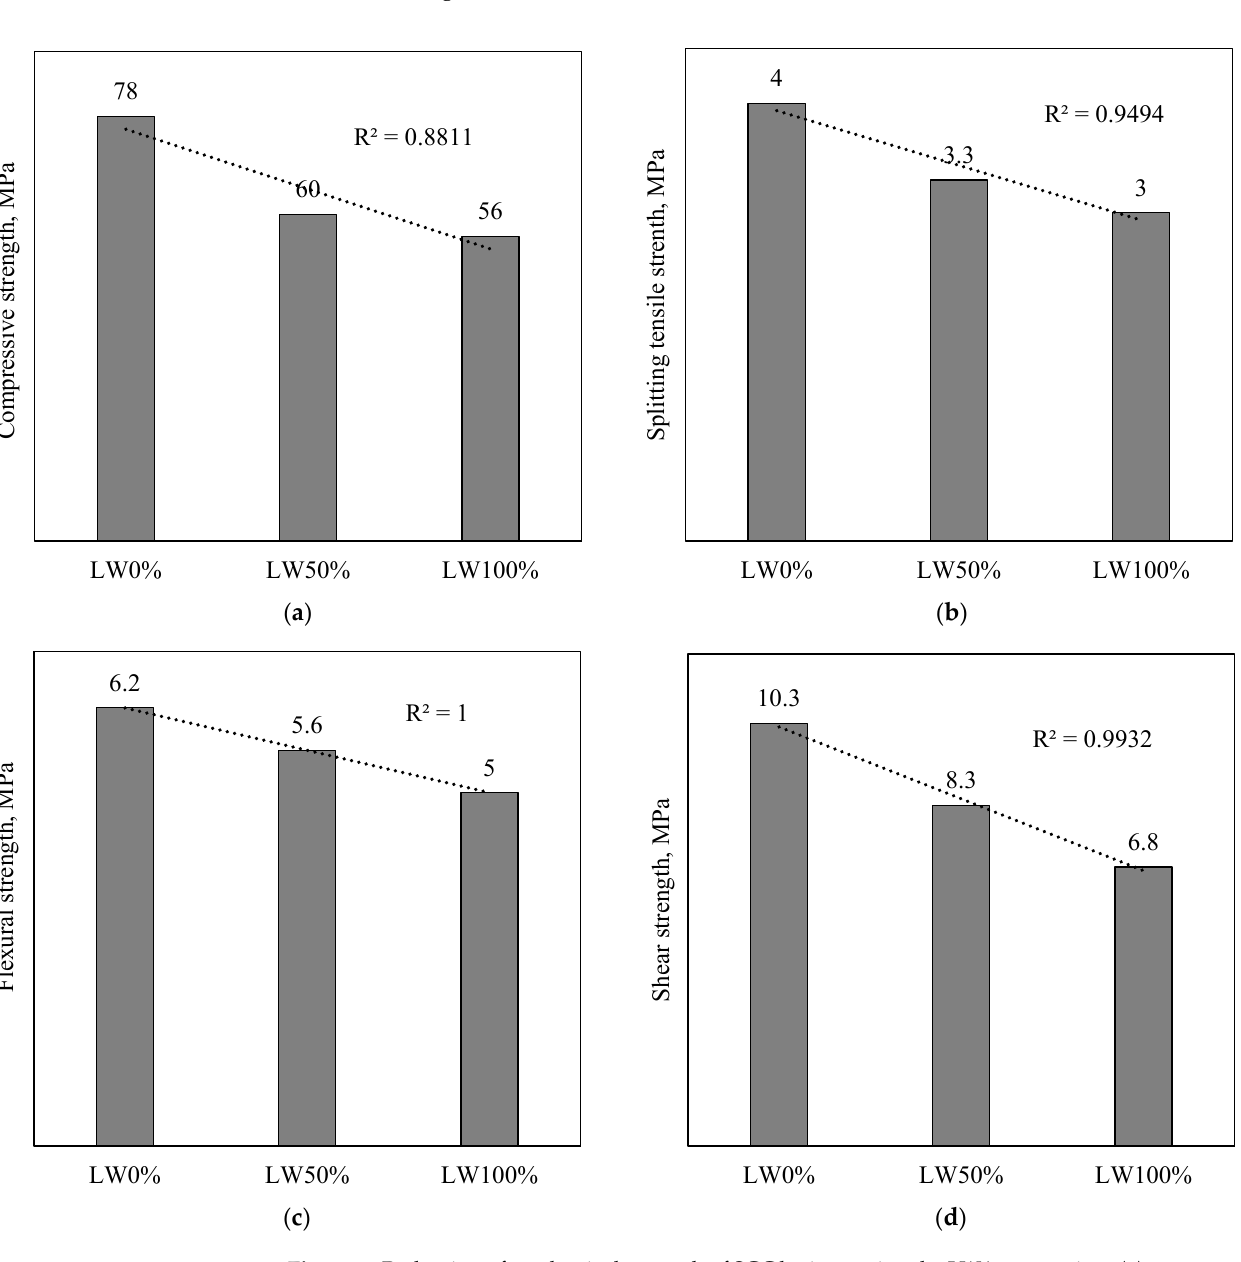
8.3 MPa, and 6.8 MPa, respectively. 3.3. Schmidt Hammer Rebound Value and Density The Schmidt hammer test is a non-destructive test used to measure the elastic properties or the concrete strength. Rebound values and density measurements were carried out on the SCC concrete cubes with different LWA proportion ratios. They were correlated linearly with a coefficient of determination of 0.99, as shown in Figure 7, as both of them were affected by the aggregate type [44]. Rebound values were influenced by LWA’s lower strength and bulk density as well as its high absorptivity. Rebound values decreased from 49.64 for LW0% (red circle) to 43.47 for LW100% (green circle), while the density of LW100% decreased by 21.2% compared to that of LW0%.